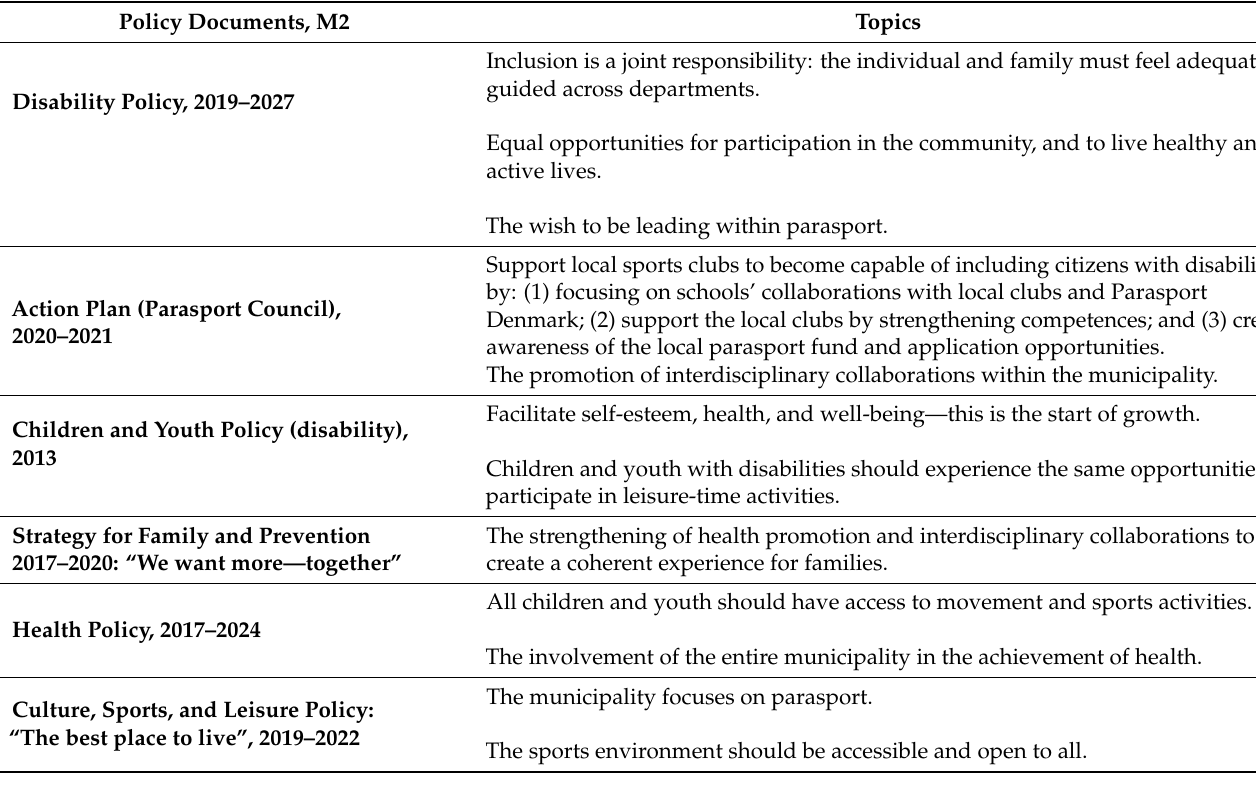
Table 4. Policy documents, Municipality 2